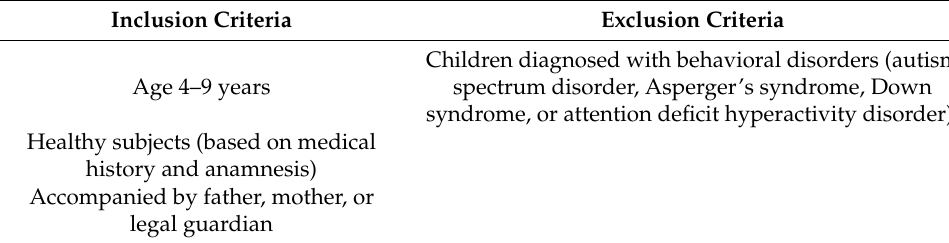
Table 3. Patient inclusion and exclusion criteria.